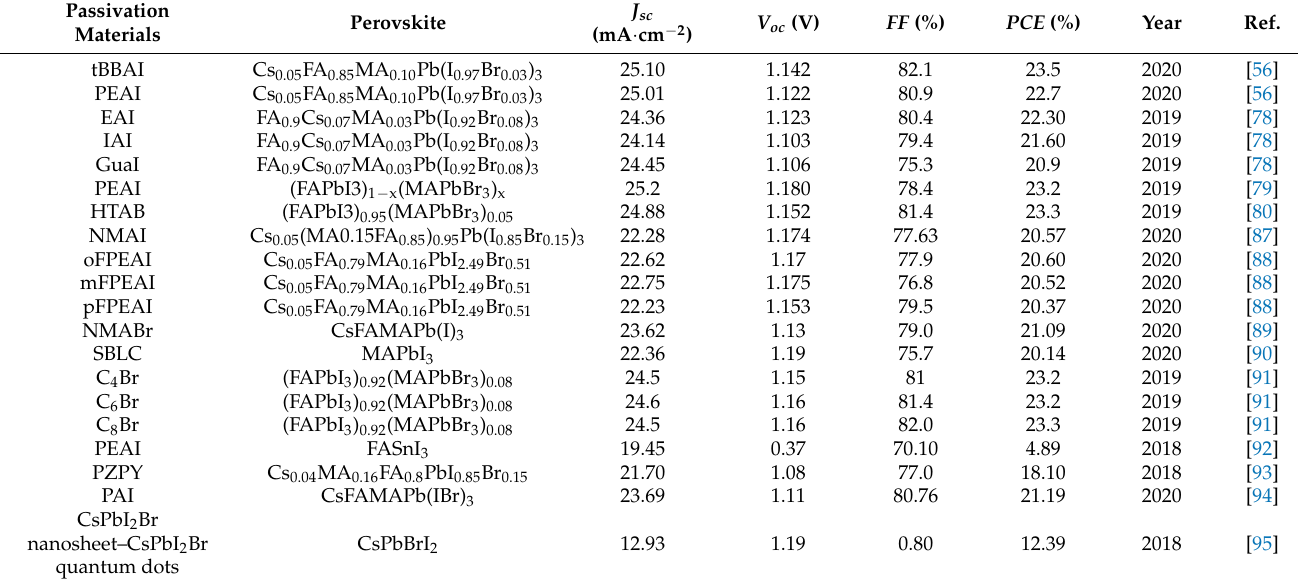
Table 1. Performance summary of organic salt passivation and graded PSCs. Passivation Materials